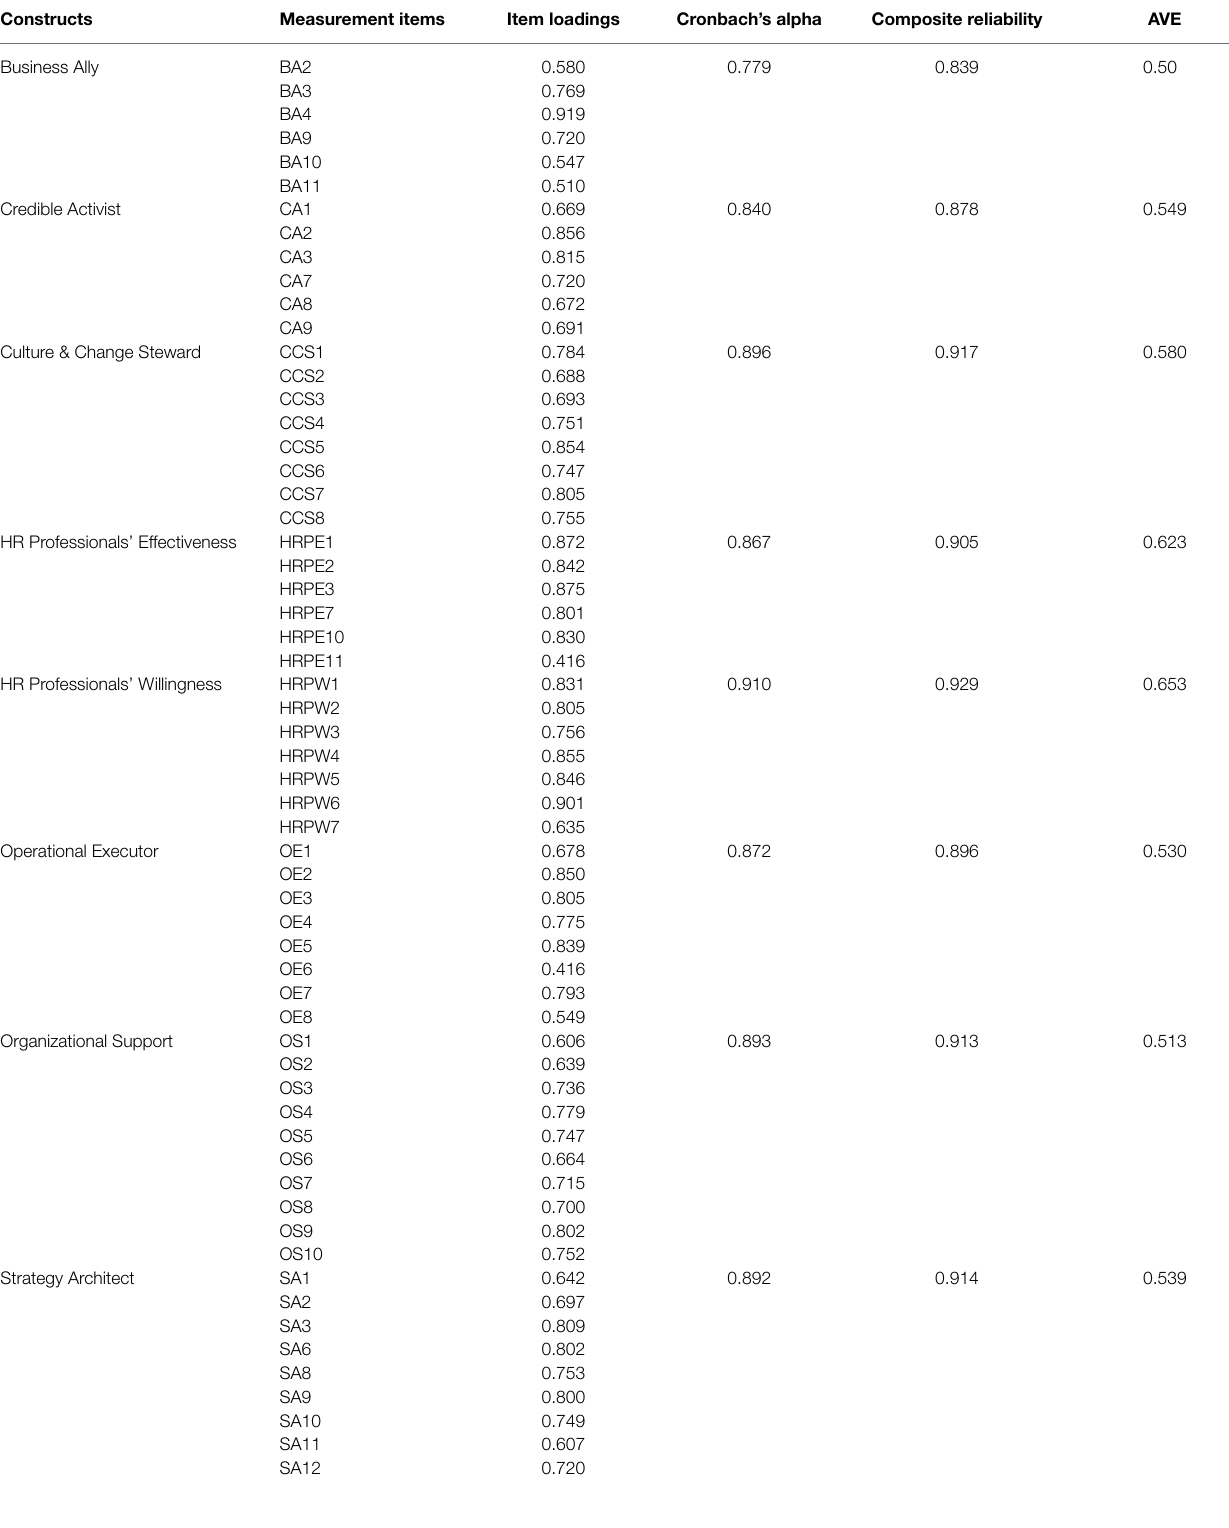
TABLE 1 | Results of convergent validity and